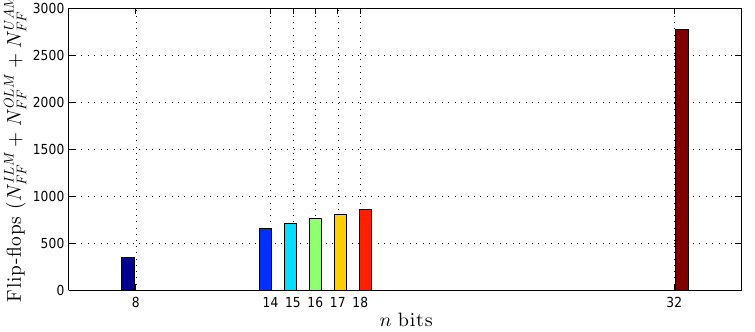
Figure 10. Area occupied (flip-flops) for different fixed point formats, in the sine function scenario.